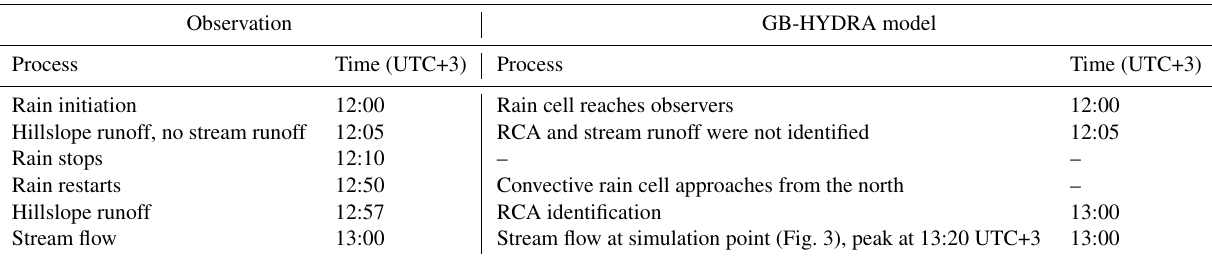
Figure 3. (a) Spatial return period maps for the studied storm. (b) Same as panel (a) , zoomed in to the Zafit subbasin. (c) Upper confidence interval (95%) for the spatial return period maps. (d) Distribution of return periods in the Zin basin. (e) Timing of the maximal rainfall intensities which was used to produce panels (a) – (d) . All properties are presented for durations of 0.5–72h. Zin basin and Zafit subbasin are outlined in black. Table 3. Field observations and model simulation results for the 26 April flash flood in Zafit